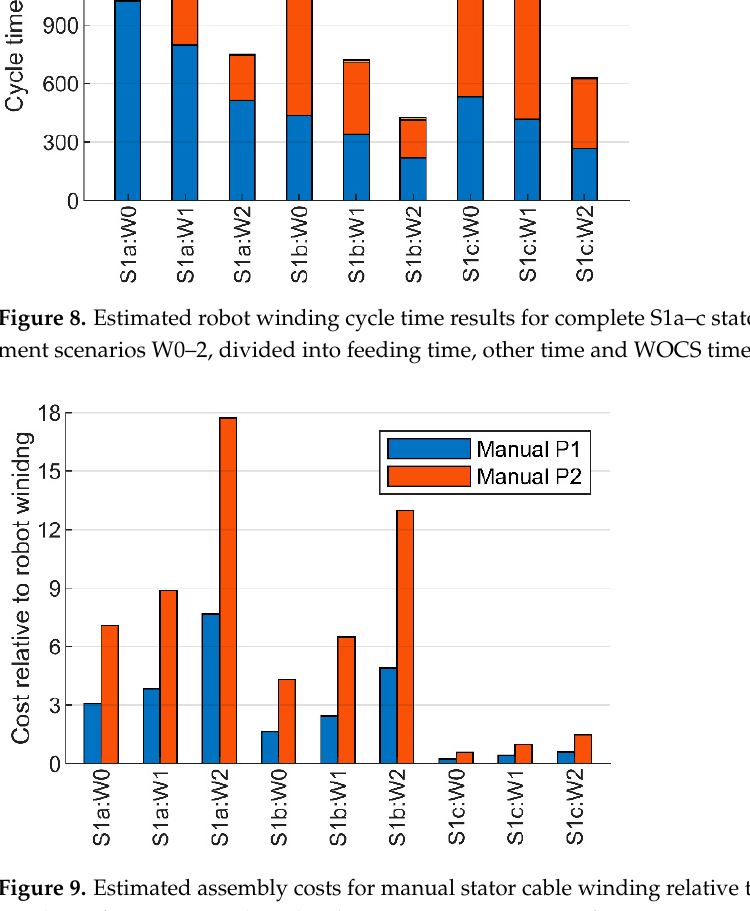
Figure 8. Estimated robot winding cycle time results for complete S1a–c stators in winding devel- opment scenarios W0–2, divided into feeding time, other time and WOCS time.